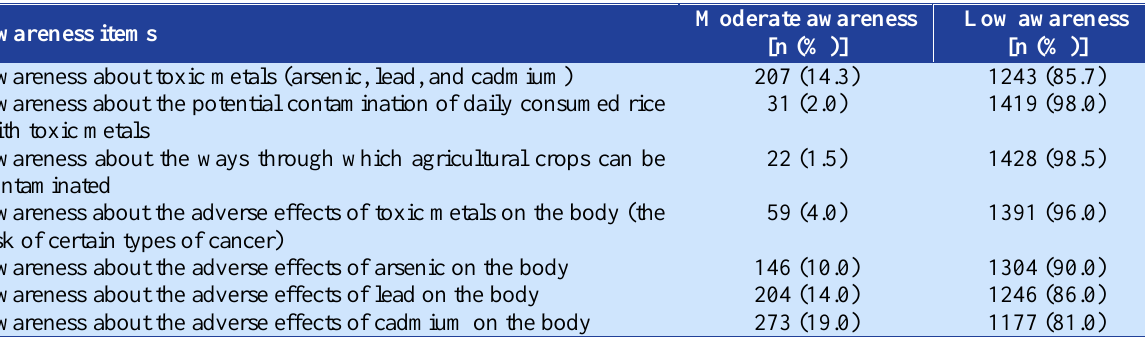
Table 2. Awareness level across the awareness items of contamination of consumed rice with toxic